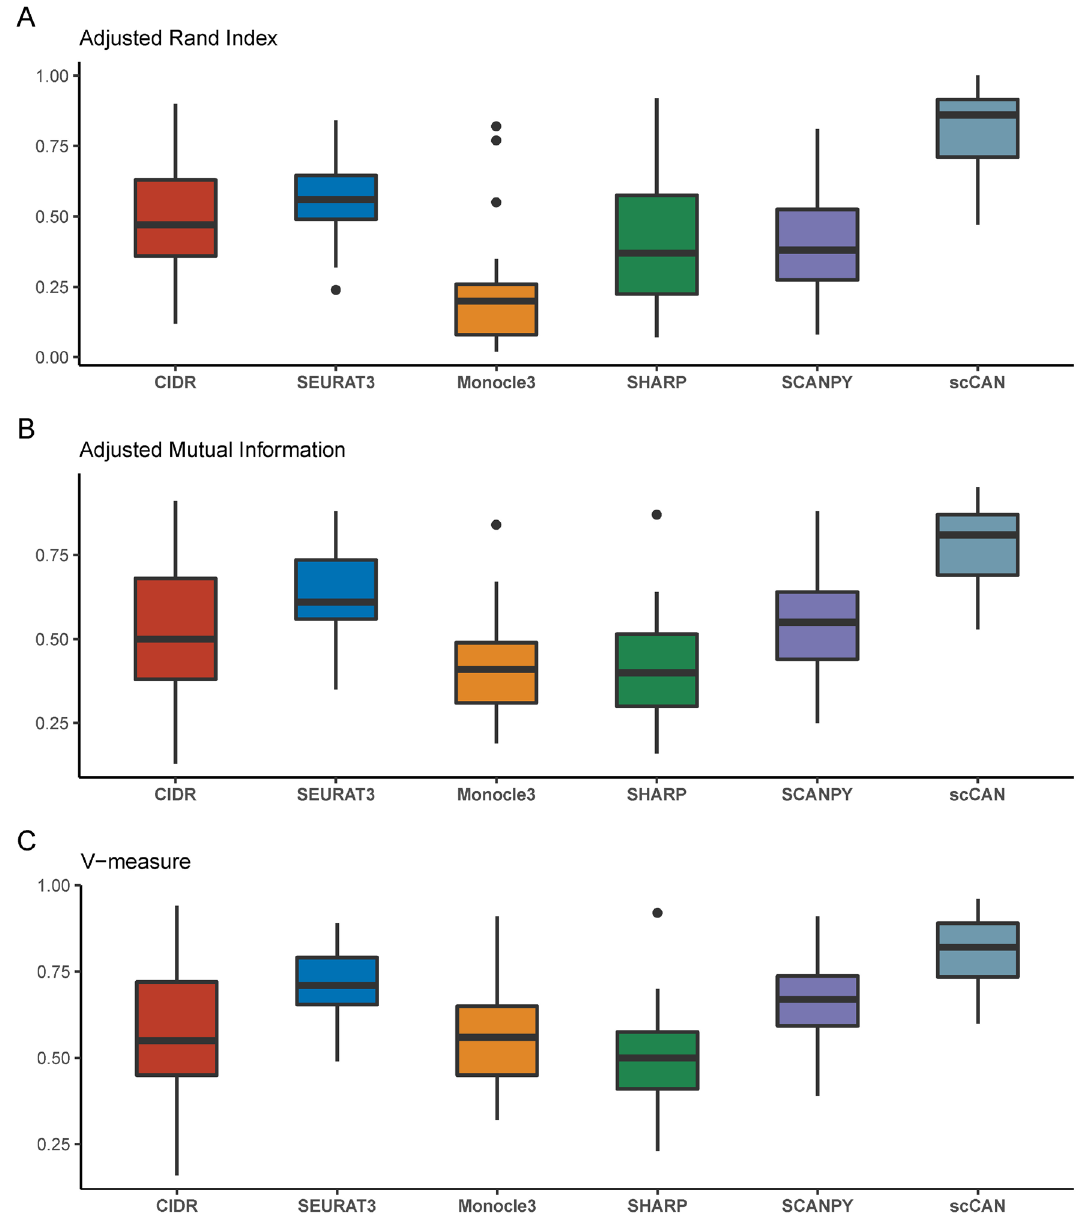
Figure 3. Accuracy assessment of the six clustering methods using adjusted Rand index (ARI), adjusted mutual information (AMI), and V-measure. scCAN consistently and substantially outperforms other methods in every assessment by having the highest ARI, AMI, and V-measure values across 27 real scRNA-seq